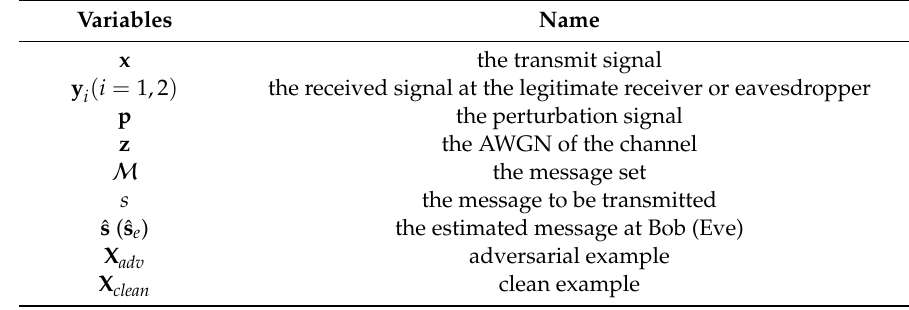
Table 2. Vocabulary table.